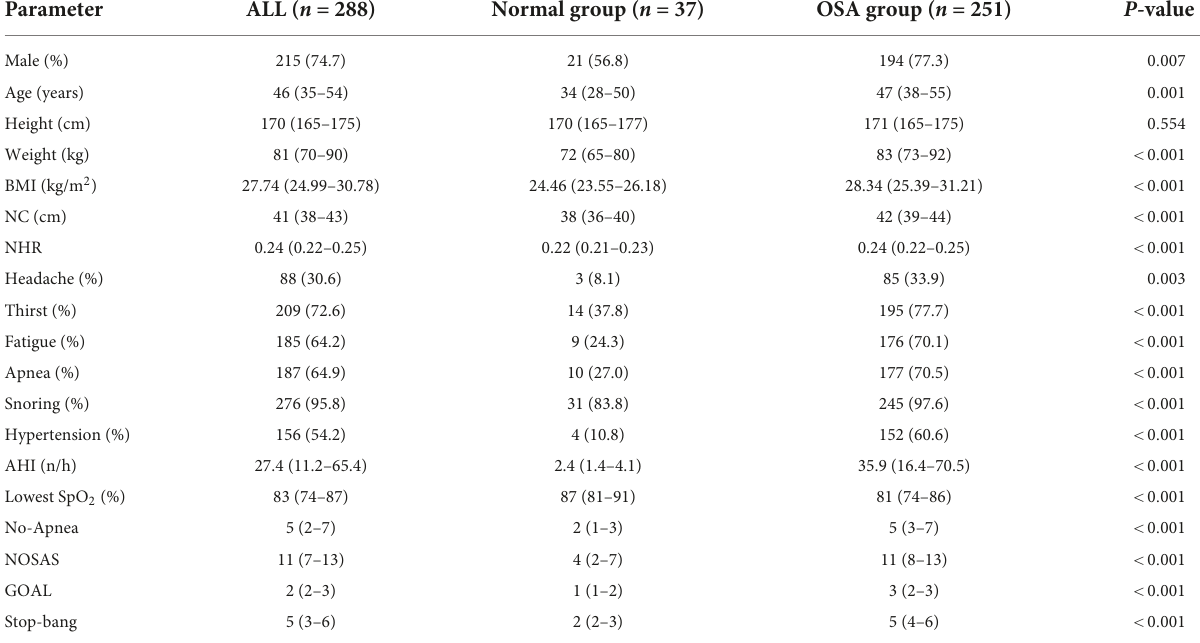
TABLE 1 General information on the study population ( n = 288).